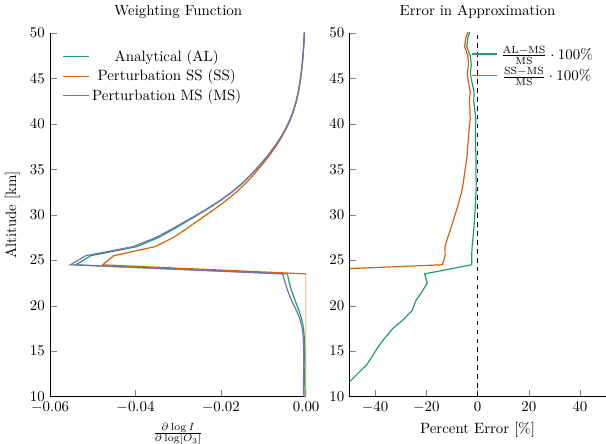
Figure 3. Ozone weighting functions at a wavelength of 330nm for a line of sight with tangent altitude 24.5km. Shown are the results for the analytical method (AL), the finite-difference method when single scattering is only considered (SS), and the finite-difference method when multiple scattering is included (MS). The right panel shows the error in the analytical and single-scattering methods com- pared to the multiple scattering